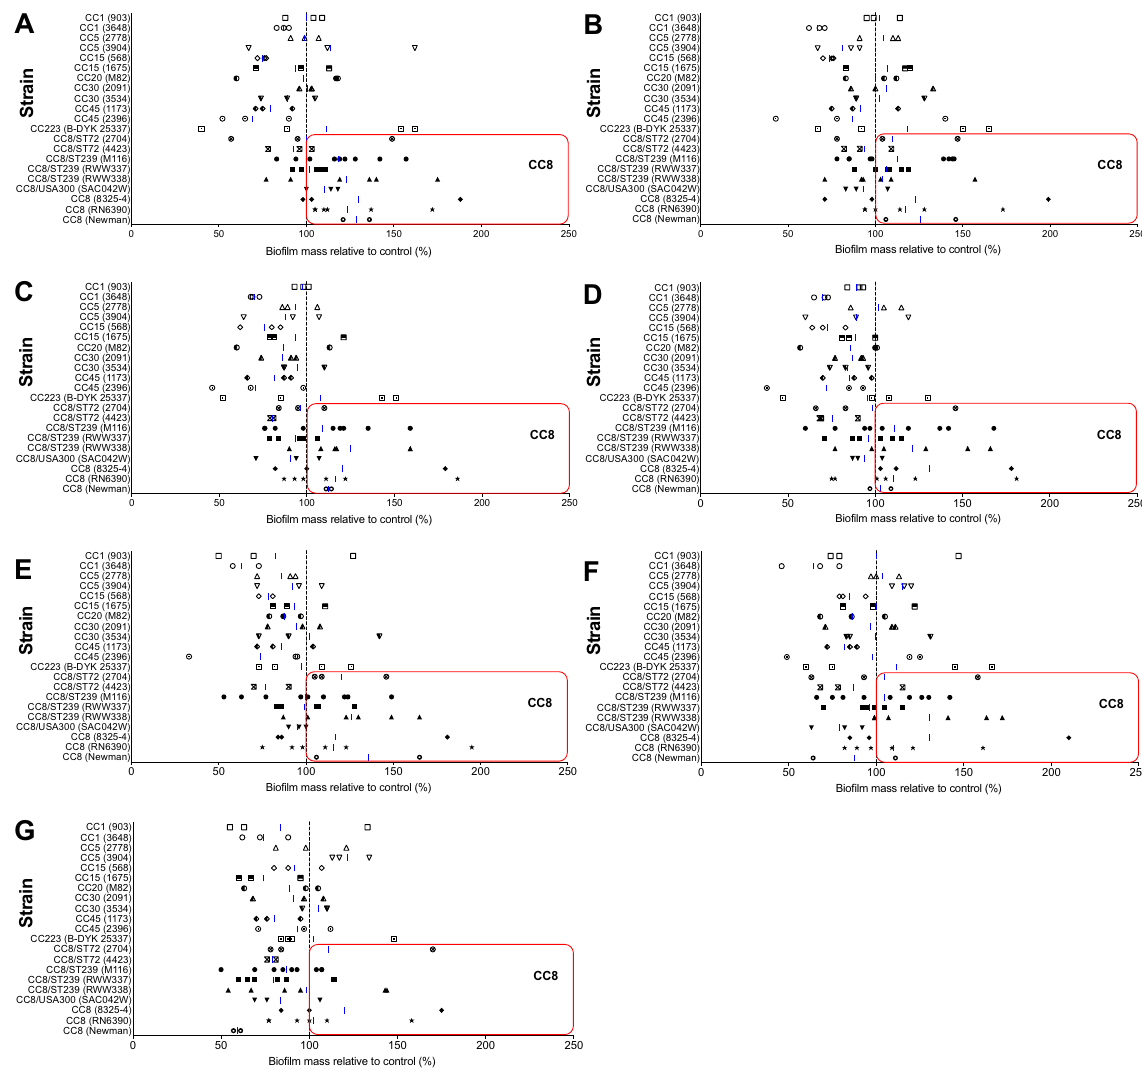
Figure 2. Staphylococcus aureus biofilm mass changes in response to various concentrations of paracetamol. Paracetamol stimulates and reduces biofilm formation at clinical doses in strains with different genetic backgrounds, most notably those belonging to CC8 including ST239. Biofilms were grown and co-incubated with 0.5 ( A ), 1 ( B ), 2 ( C ), 4 ( D ), 8 ( E ), 16 ( F ), and 32 ( G ) μg/mL of paracetamol. Red boxes outline the biofilm mass increase of CC8 strains above control mass. Data from at least three separate experiments are presented as aligned dot plots with a blue line indicating the mean